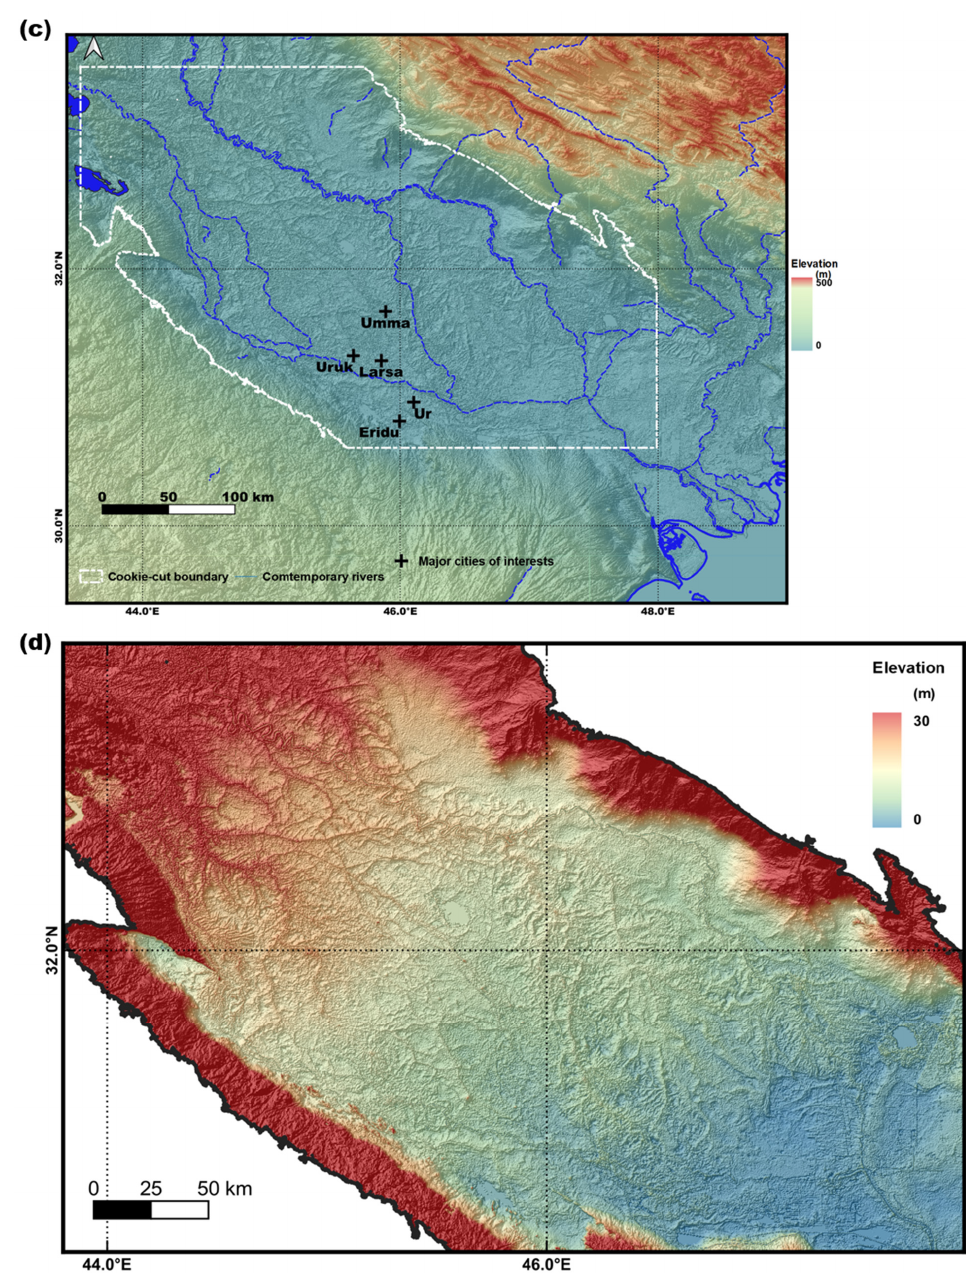
Figure 2. ( a ) Sumerian-era cities superimposed on a Google Earth image. ( b ) Google Earth image with ancient channels overlaid. The routes of ancient rivers and canals were identified using high- resolution imagery [30]. ( c ) The topography of the study area, as well as the major cities. ( d ) Cookie- cut hill shading image of the Euphrates–Tigris fl oodplain. Note the delineated channels over the background topography in comparison to ( b ).